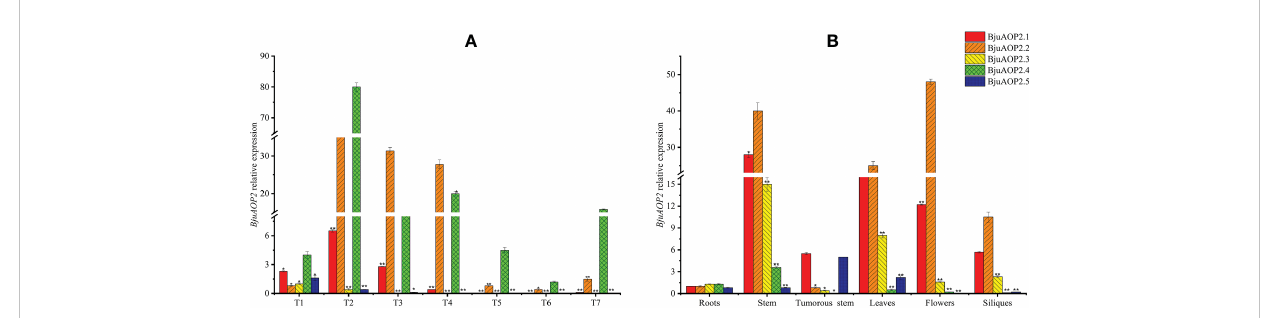
FIGURE 6 Expression pattern of BjuAOP2 in different tissues and different developmental periods. The vertical axis indicates gene expression levels relative to BjuAOP2.5 expression in roots (A) and BjuAOP2.2 expression in 4 weeks after sowing. T1-T7 represent the seven times 4, 7, 10, 13, 16, 19, and 22 weeks after sowing (B) . Error bars represent the standard deviation from three biological repeats. * and ** indicate signi fi cant differences at P<0.05 and P<0.01 using ANOVA analysis followed by a Duncan test,